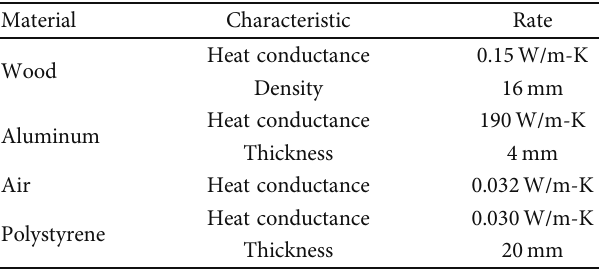
convective resistant. Table 1: Material properties utilized for evacuated tube collector.